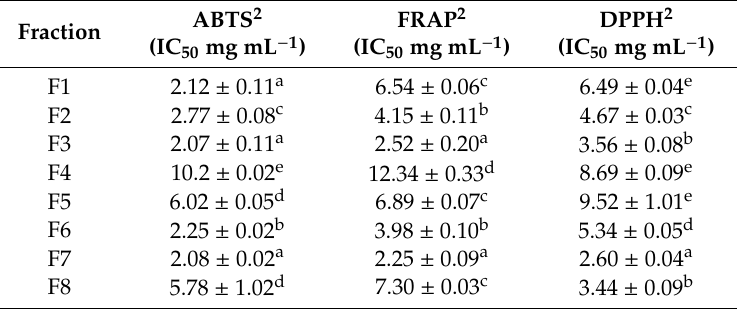
Table 1. Antioxidant activity of the collected fractions of squid skin extract, evaluated by three methods. 1